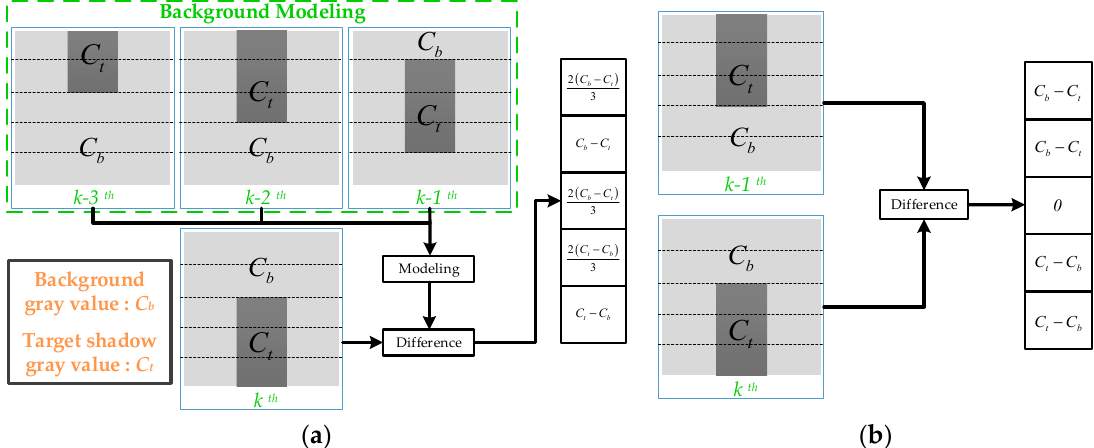
Figure 1. Principle of shadow extraction of difference-based MTD algorithms. ( a ) Principle of background difference. ( b ) Principle of frame difference. The blue rectangles represent frames.